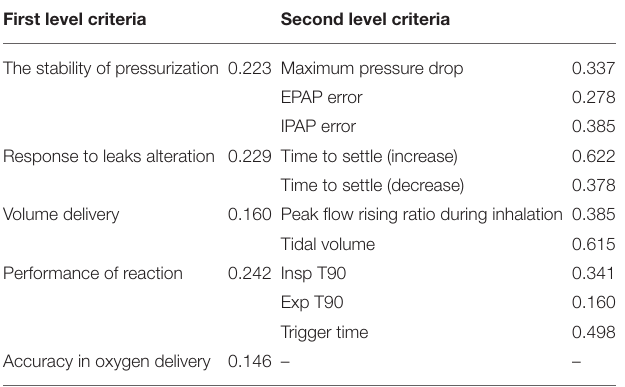
TABLE 3 | The final weights of nodes of the scoring system. First level criteria